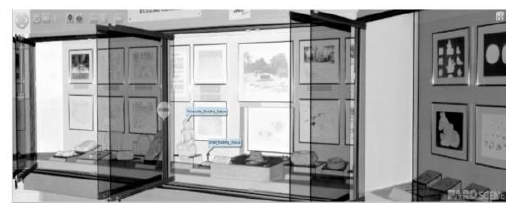
Figure 20. Documentation object of the Terracotta Buddha